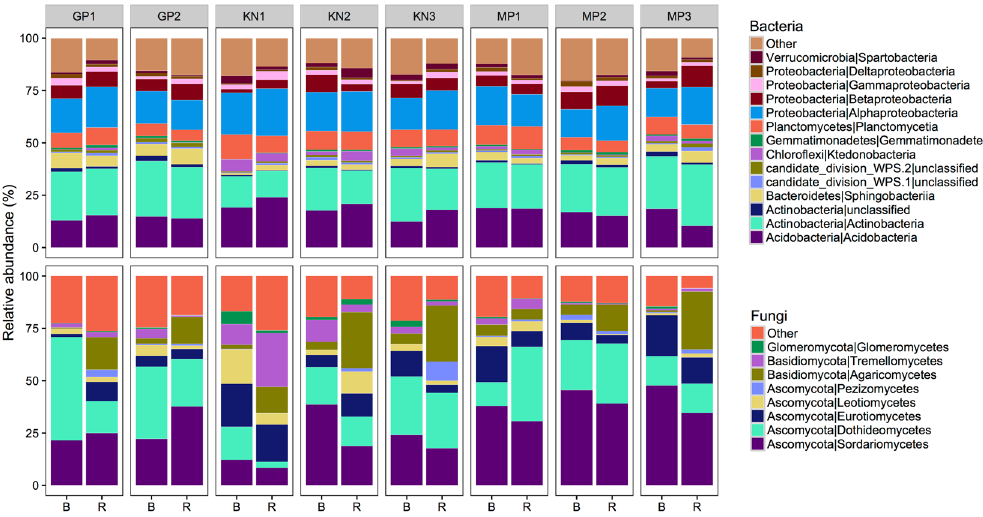
Figure 1. Mean relative abundances of taxa (phylum/class levels) within each location. The abundance of each taxon was calculated as the percentage of sequences per location for a given microbial group. The group ‘Other’ encompasses unclassified sequences together with classes representing ≤ 0.5% of total sequences. B, bulk soil; R, rhizosphere